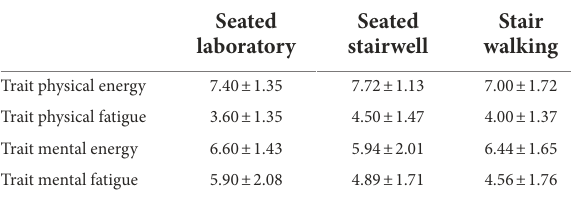
TABLE 2 Trait energy and fatigue scores (M ± SD) by group.